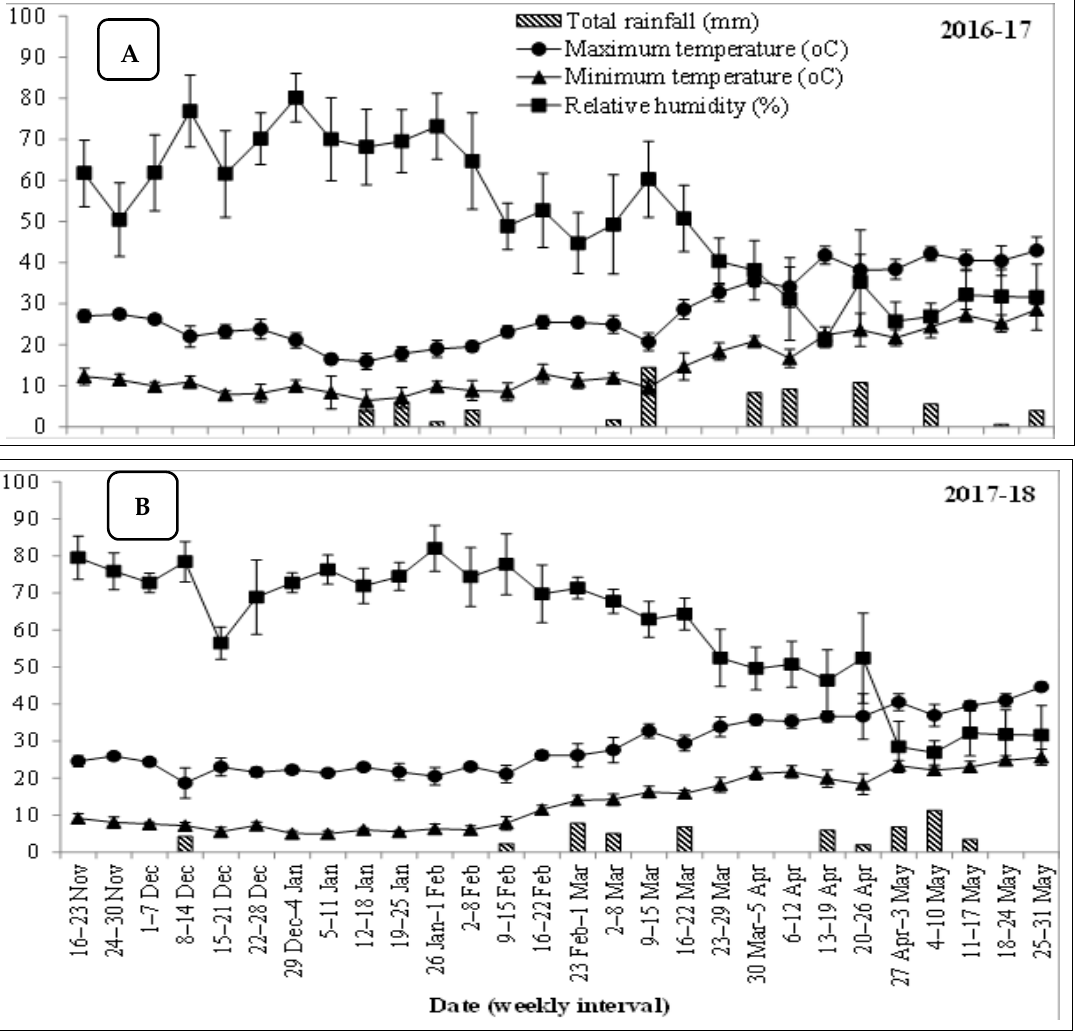
Figure 1. Weather data including maximum temperature, minimum temperature, relative humidity and rainfall of experimental station during crop growing seasons of 2016–2017 ( A ), and 2017–2018 ( B ).